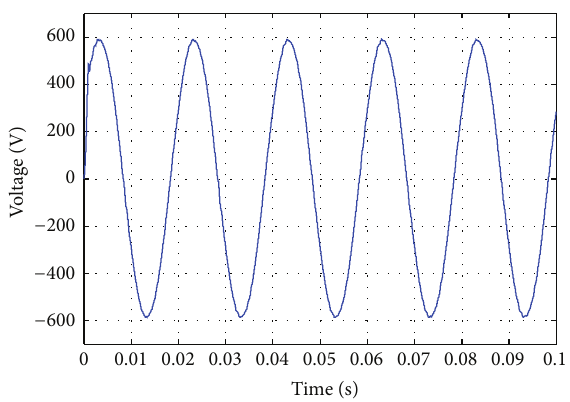
Figure 21: Line voltage ( 𝑉 𝑎𝑏 ) of the three-phase inverter with nonlinear load.